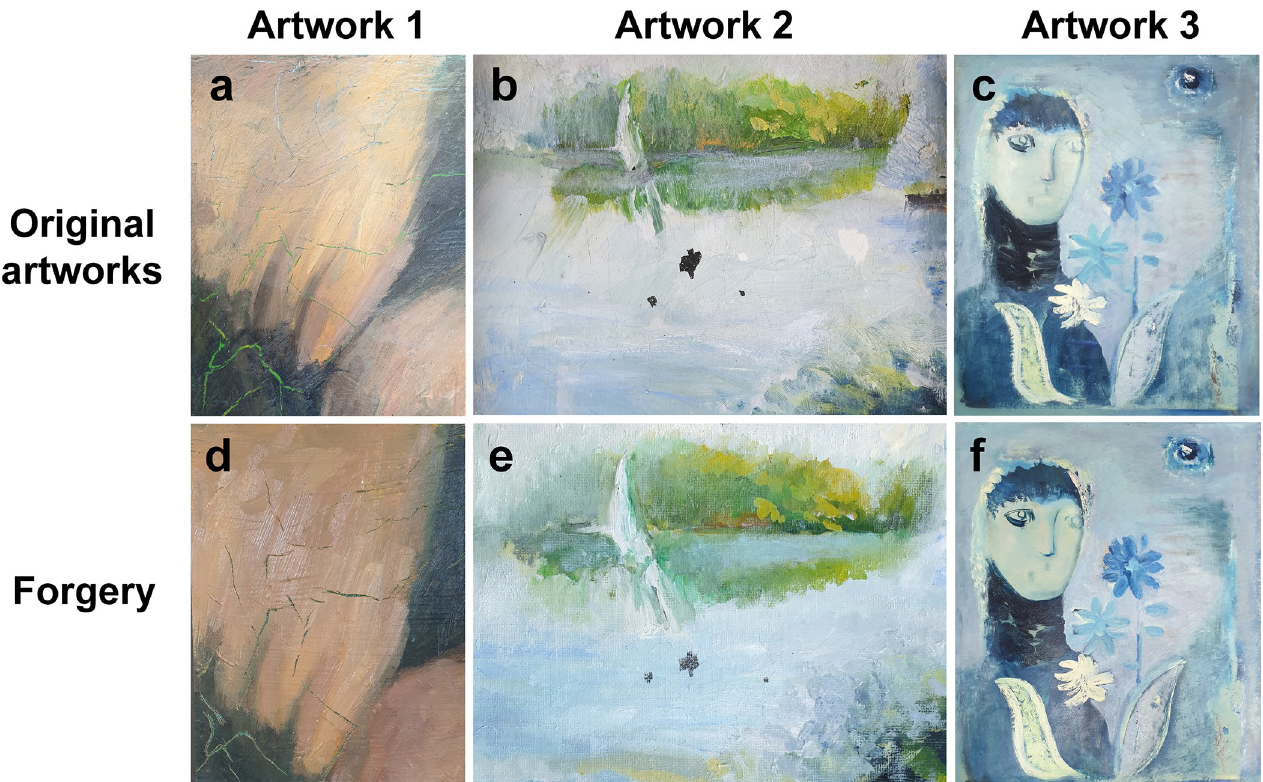
Fig 2. Original oil painting (a, b, and c) and counterfeit works (d, e, and f). They were prepared for an analysis of the three-dimensional forms of cracks used for authenticity identification of art works. The forgeries were completed by checking the color combination of the original work, the artist’s brushstroke style, and the thickness of the paint layer as much as